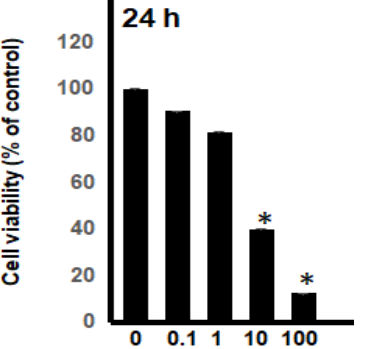
Figure 4. Effect of buxifoliadine E on LNCaP cancer cell death. * p < 0.05.